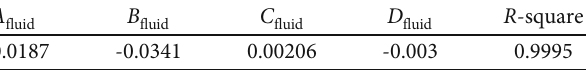
Table 2: Cubic polynomial fi tting coe ffi cients.